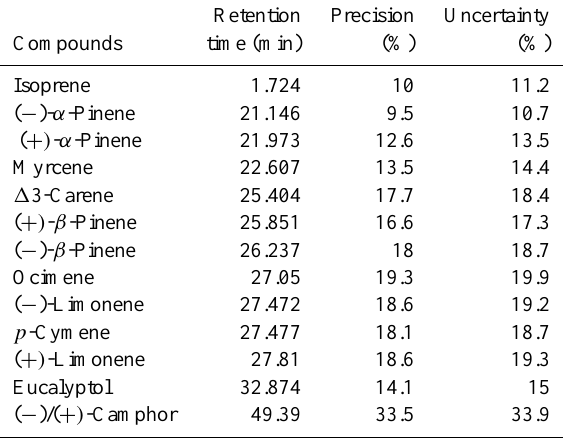
Table 1. Overview of the measured compounds. Retention